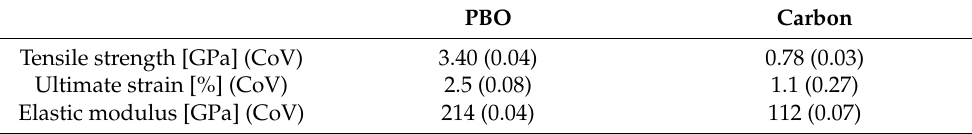
Figure 2. Tensile test on dry fiber: ( a ) PBO Fibers and ( b ) C Fibers. Table 1. Mechanical properties of the PBO and Carbon